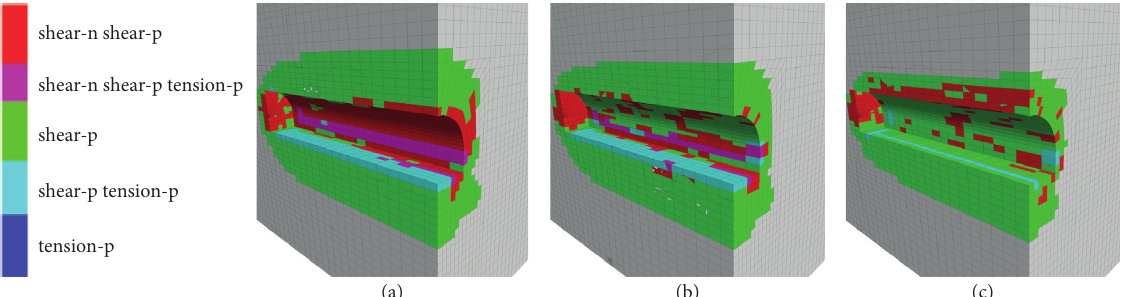
Figure 16: State of plastic zone. (a) Unsupported. (b) Primary support. (c) Secondary